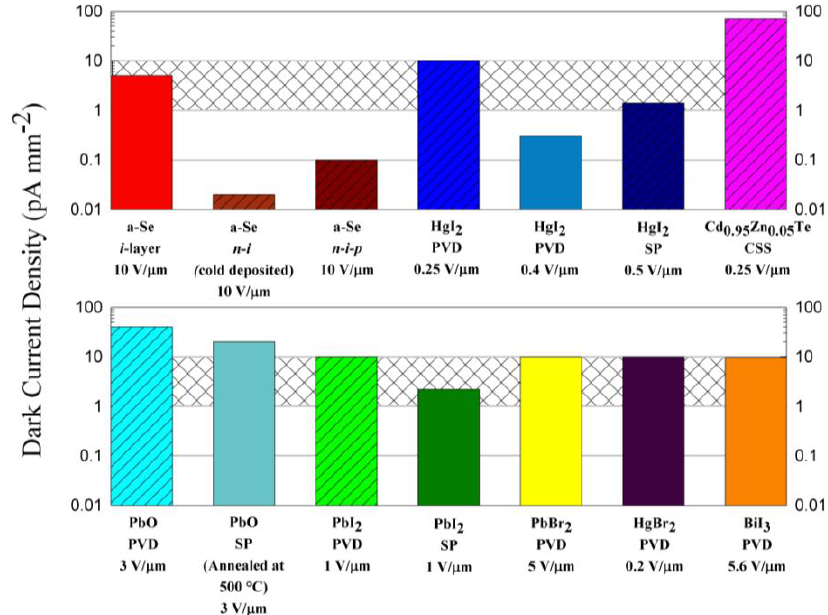
Figure 13. The best reported values to date of dark current density for a-Se and polycrystalline photoconductive layers. Note that most of these are measured at relatively low applied electric fields where it is questionable that the charge collection efficiency is adequate. It is not possible to scale these to the same field as the field dependence of the dark current is rarely linear and in general is unknown. All polycrystalline layers are labeled as deposited by physical vapour deposition (PVD), screen printing (SP) or close space sublimation (CSS). Solid colors represent values obtained from films that have not yet been used to obtain x-ray images, hashed bars represent values from demonstrated x-ray imagers. The grey hashed area represents the acceptable range for dark current in an FPXI. Data have been taken from various sources, including the following: a-Se ( i -layer and n-i-p ) from [15], a-Se ( n-i ) from [118], HgI (PVD at 0.25 V/  m and SP) from [51], 2 HgI (PVD at 0.4 V/  m) from [122], PbI (PVD) from [56], PbI (SP) from [48], 2 2 2 Cd Zn Te from [58], PbO (PVD) from [59], PbO (SP) from [123], PbBr and HgBr 0.95 0.05 2 2 from [124] and BiI from 3